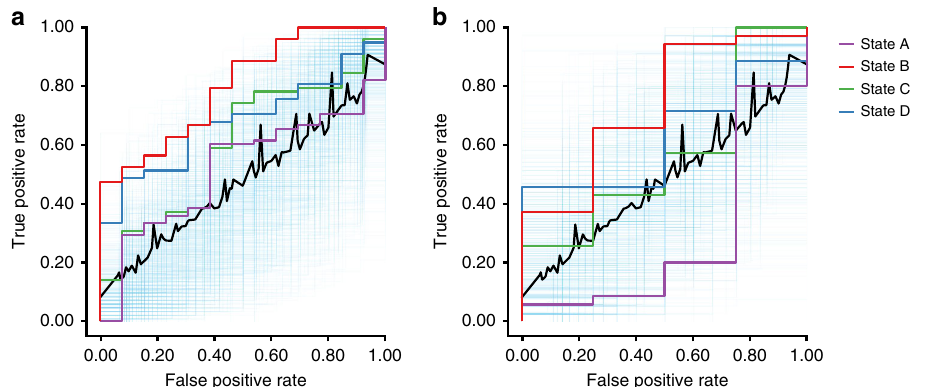
Fig. 9 Speci fi c brain states are predictive of distinct clinical symptoms in novel individuals. a State B 4 uniquely predicted the presence of active psychosis in patients with psychotic illness. Results from a leave-one-subject-out cross-validation elastic net logistic regression analysis comparing predicted and observed psychotic symptoms ( n = 91). The displayed area under the receiver-operating characteristic curve (AUC) re fl ects the scalar probability measure for each individual, predicting the likelihood of active psychotic symptoms. The blue semitransparent lines re fl ect 1000 ROC curves from 1000 permutation experiments. The black dashed line indicates the mean of these 1000 curves, approximating a null curve. The purple, red, green, and orange curves correspond to states A 4 , B 4 , C 4 , and D 4 , respectively. b Connectivity models de fi ned on training data predict the presence of active psychotic symptoms in an independent group of participants ( n = 31). The displayed AUC graph re fl ects the scalar probability measure, predicting the likelihood of active psychosis, de fi ned using positive edges from the initial training set without further fi tting or modi fi cation, in a held-out sample of